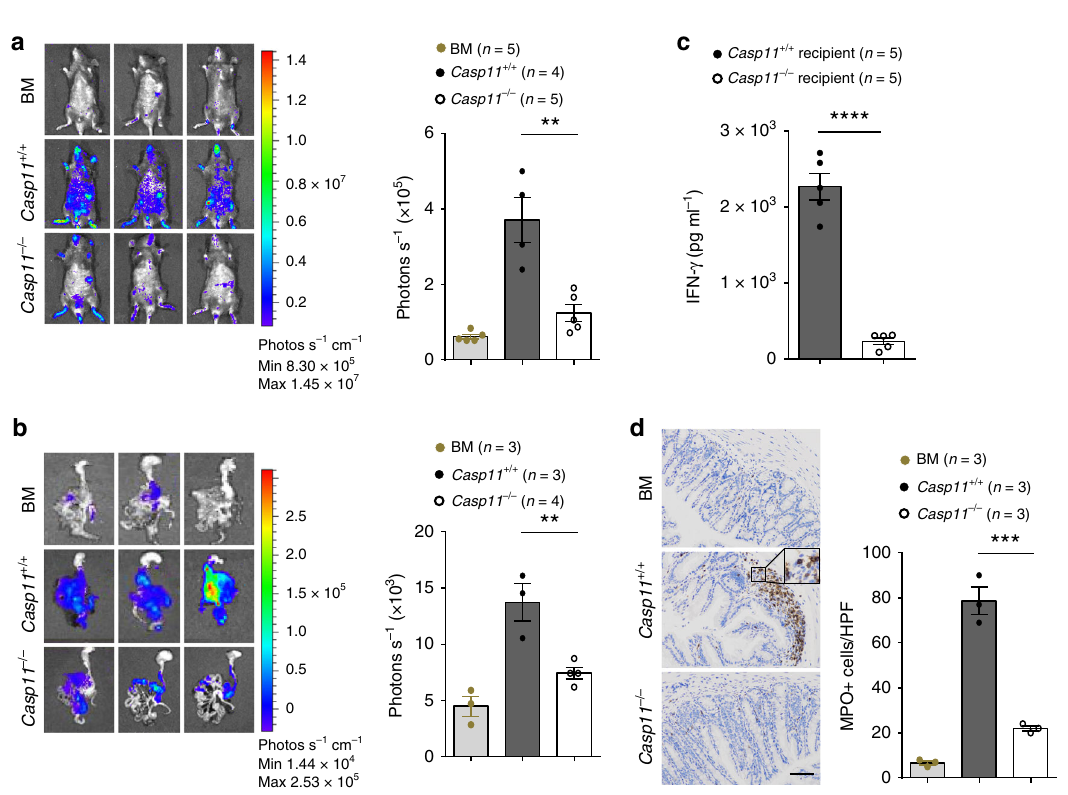
Fig. 2 Caspase-11 enhances donor T cell expansion in allogeneic hematopoietic stem cell transplantation (allo-HSCT). a Fourteen days post transplant, Casp11 + / + and Casp11 − / − recipients receiving BALB/c bone marrow and T cells were subjected to intraperitoneal luciferin injection and whole-body bioluminescent imaging (BLI) are depicted. Region of interest gating and signal normalization with Living Image software. Average representative whole- body images, and average bioluminescence intensities ± SEM were depicted. (** P = 0.0040; an unpaired Student ’ s t test (two-sided) was used). b Fourteen days post transplant, Casp11 + / + and Casp11 − / − recipients receiving BALB/c bone marrow and T cells were subjected to intraperitoneal luciferin injection and whole-body BLI followed by a second luciferin injection, euthanization, organ removal, and BLI of graft-versus-host disease (GVHD) target organs of intestines. Bioluminescence was quanti fi ed using whole organ region of interest gating and signal normalization with Living Image software. Average representative ex vivo organ images, and average bioluminescence intensities ± SEM were depicted. (** P = 0.0089; an unpaired Student ’ s t test (two-sided) was used). c Interferon- γ (IFN- γ ) in the serum of mice receiving BM and T cells (groups described in a , BALB/C (donor), C57BL/6 (recipient) model, day 5 after allo-HSCT). Data (mean ± SEM) are pooled from two independent experiments (**** P < 0.0001, an unpaired Student ’ s t test (two-sided) was used). d Representative colon tissue section of Casp11 + / + recipient mice versus Casp11 − / − recipient mice (BALB/c → C57BL/6 combination) receiving BALB/c bone marrow and T cells is shown. Staining in brown is for myeloperoxidase as indicated for the respective tissues. The frequency of myeloperoxidase positive (MPO + ) cells per high power fi eld (HPF) was signi fi cantly lower in the caspase-11-de fi cient recipients than those of in wild-type (WT) recipients. Data are presented as mean ± SEM (*** P = 0.0008, an unpaired Student ’ s t test (two-sided) was used). Scale bar: 100 μ GBPchr3 KO recipient mice following allo-HSCT (Fig. 3g). circulating LPS levels (Supplementary Fig. 4a, b). Accordingly, Conversely, intraperitoneal (i.p.) administration of LPS after allo- cipro fl oxacin treatment signi fi cantly improved survival in WT HSCT signi fi cantly promoted GVHD lethality in WT but not in but not in Caspase-11 -de fi cient recipient mice (Supplementary Caspase-11 -de fi cient or GBPchr3 KO recipient mice (Fig. 3h). Fig. 4c). Taken together, these data indicate that LPS – caspase-11 Oral administration of cipro fl oxacin signi fi cantly decreased the interaction enhances GVHD in allo-HSCT.